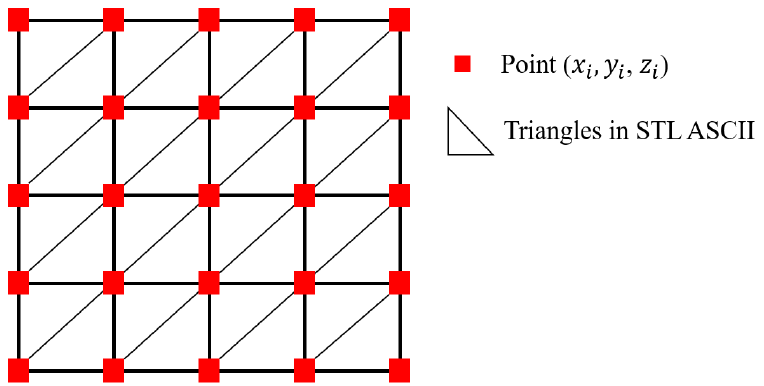
Figure 4. LiDAR data conversion to STL ASCII format.